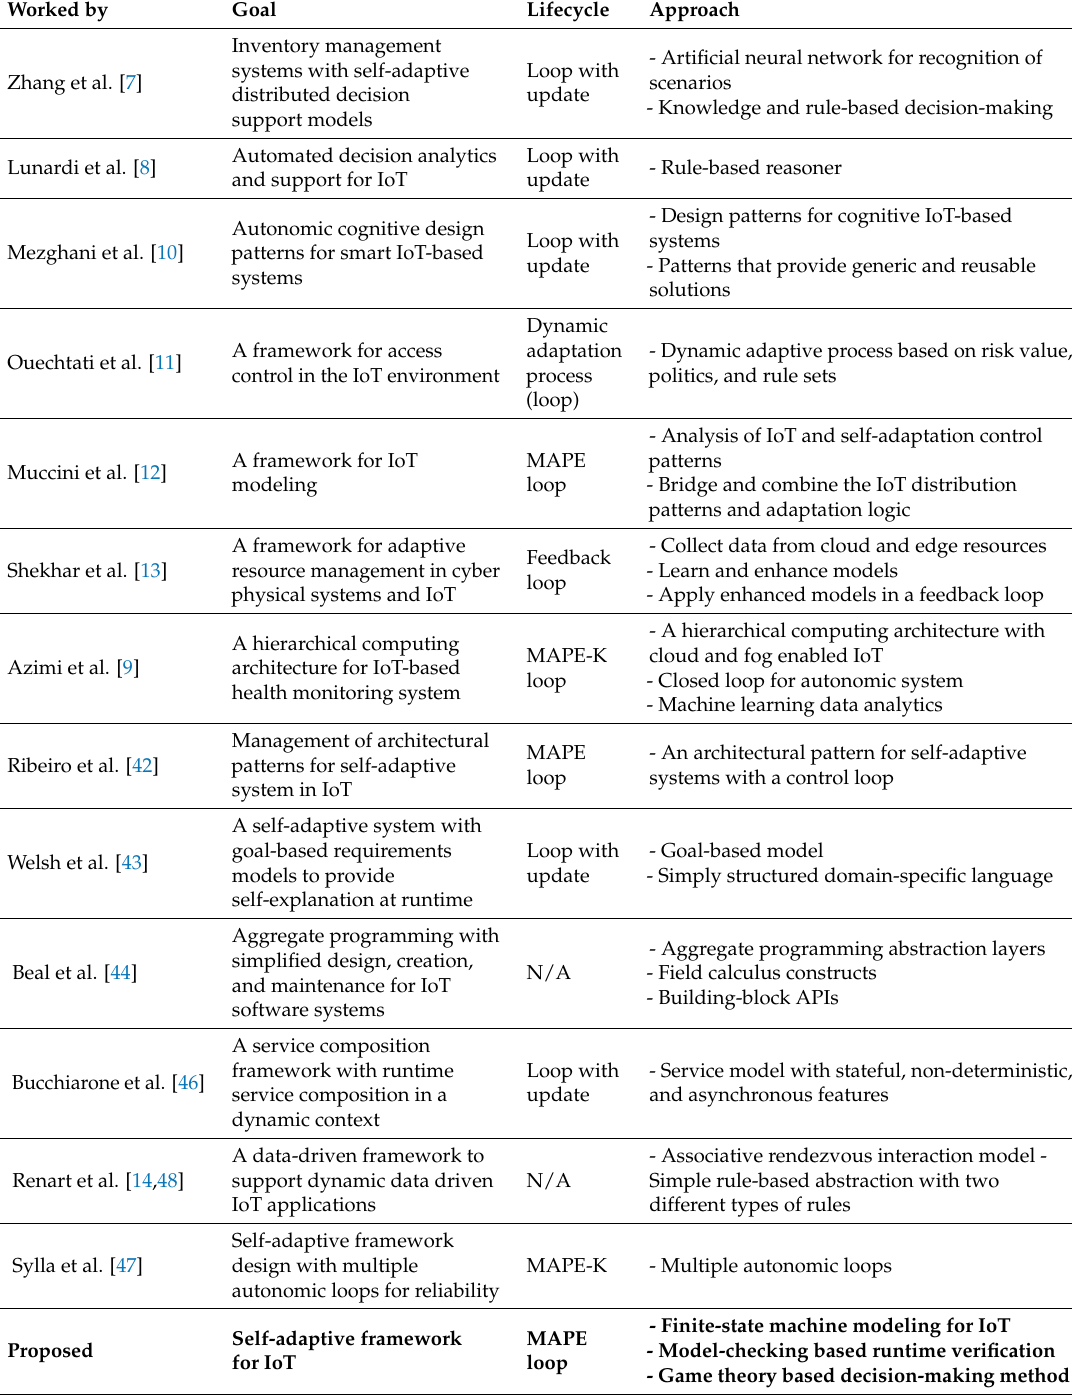
Table 1. Comparison of previous research and the proposed